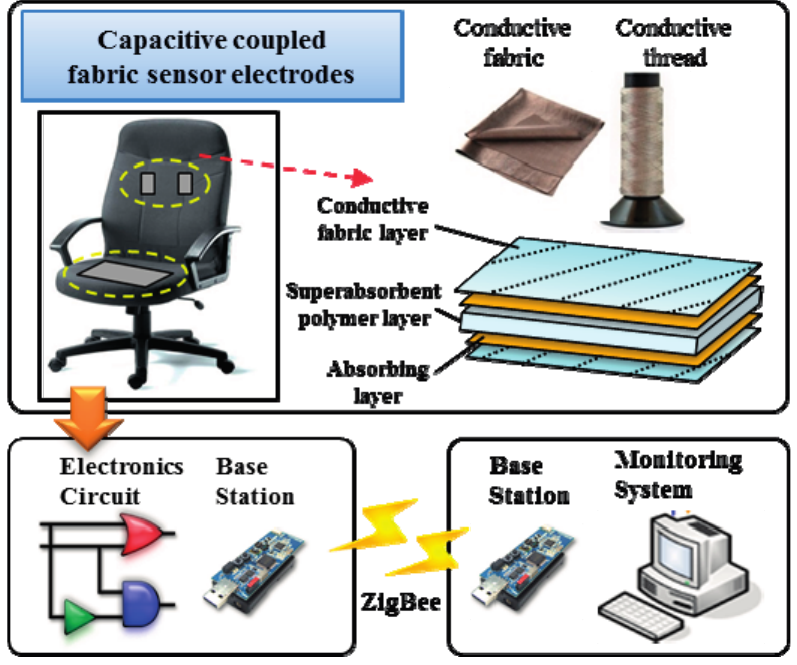
Figure 1. Non-contact ECG monitoring